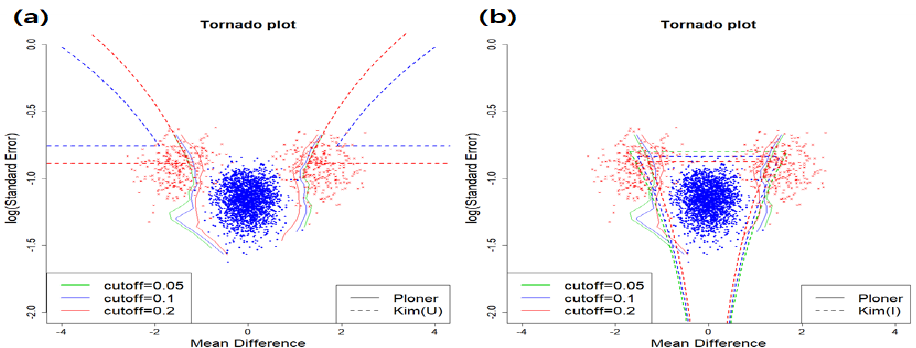
Figure 6. Mean shift scenario and two-sided. Estimated fdr2d when µ = 1.5. ( a ) Union null ( b ) Intersection null.